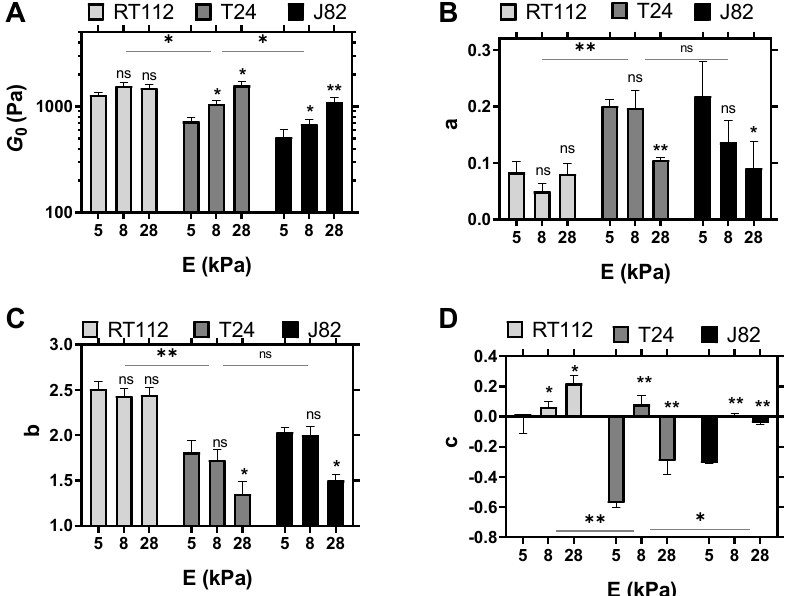
Figure 2. Parameters G 0 ( A ), exponent a ( B ), exponent b ( C ), and exponent c ( D ) for RT112, T24, and J82 cancer cells on different gels (E=5–8–28 kPa). The parameters were extracted from fitting averaged G (cid:48) and G (cid:48)(cid:48) for each condition with Equation (3). Three different adjustments were performed, and the means of the fitted parameters were obtained. N = 5; error bars represent the mean ± SEM. Asterisks represent a significant difference using the Student t -test: ns = not significant, * p < 0.05 and ** p < 0.01. For each cell line, the statistical asterisk is versus the condition 5kPa. A bar is added under the asterisk when a statistical difference is found between RT112–T24 and T24–J82 on 8 kPa